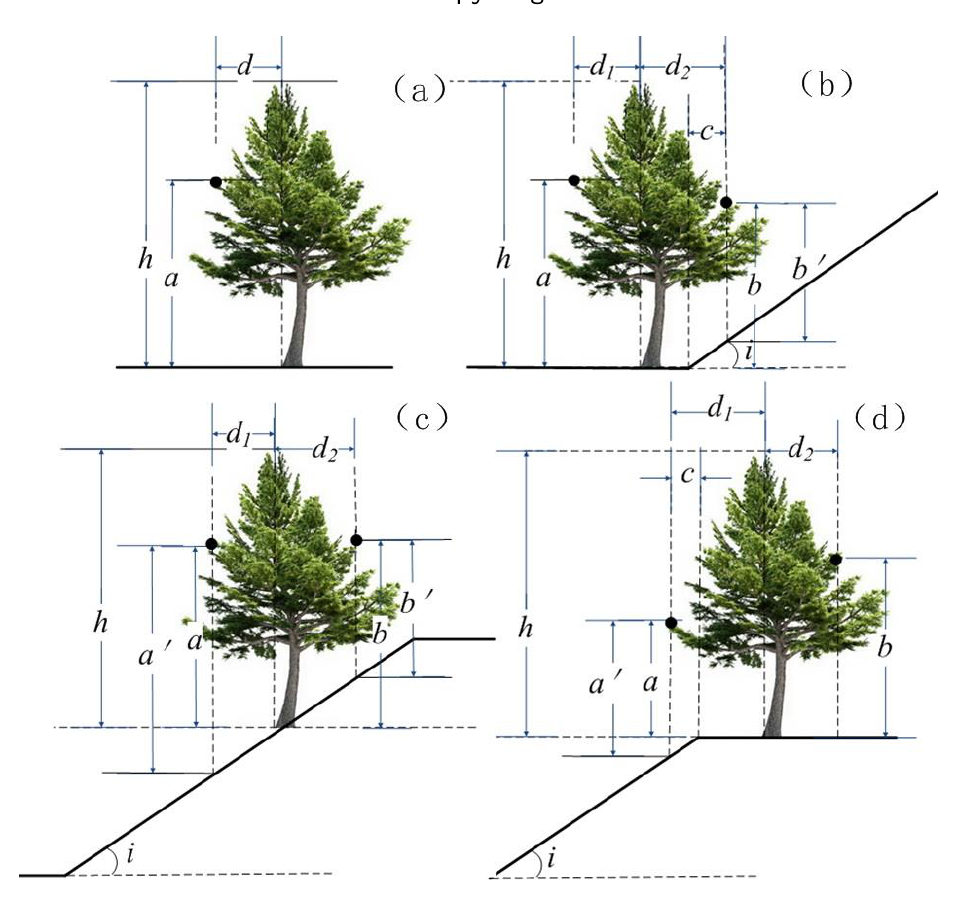
Figure 3. Influence of slope on canopy